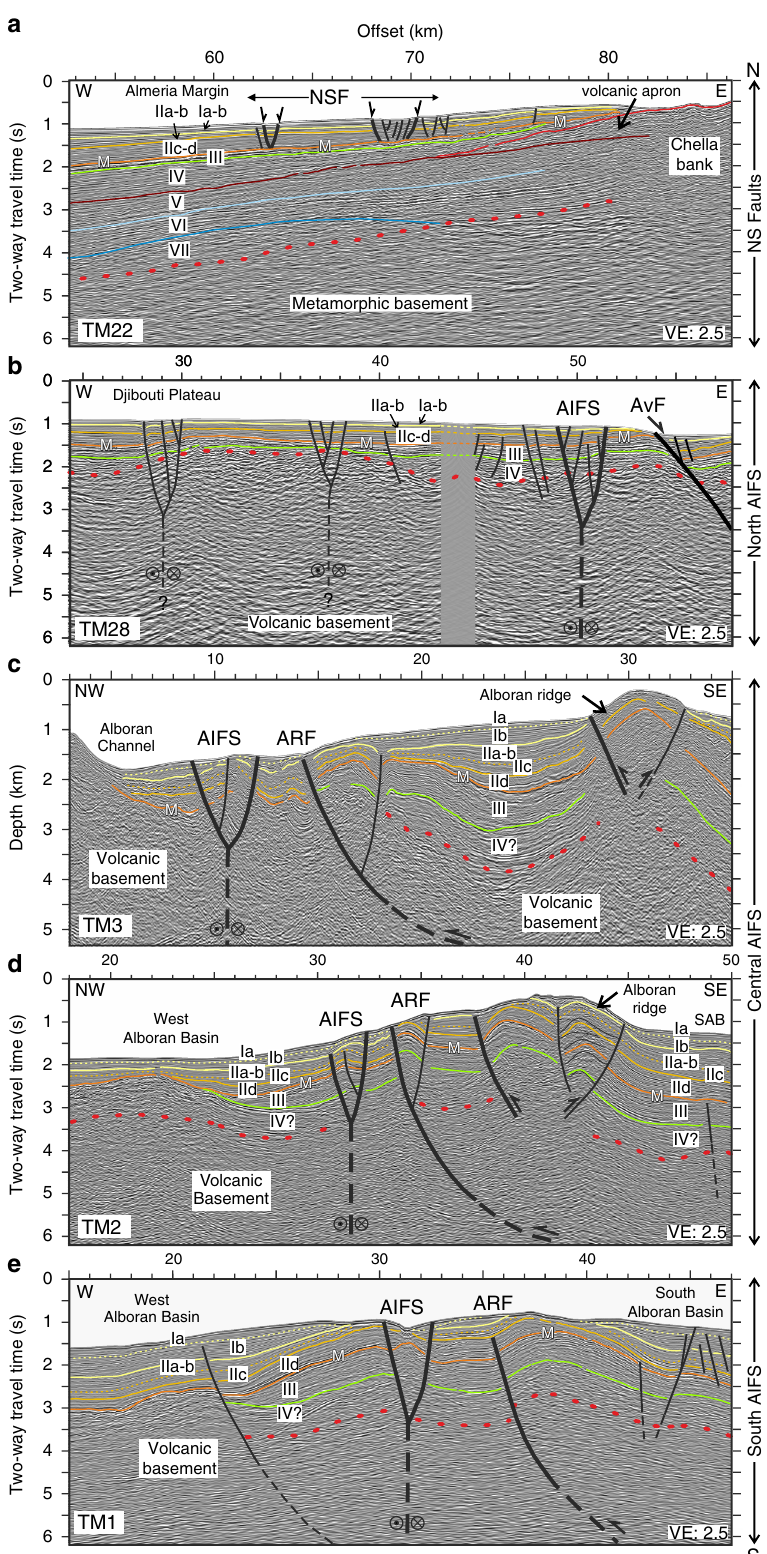
Fig. 4 Interpreted seismic re fl ection pro fi les across the AIFS. From north (top) to south (bottom), multichannel seismic pro fi les illustrate the geometry and tectonic pattern of the AIFS. The fi ve pro fi les are located in Fig. 2a. a NSF (pro fi le TM22); b North AIFS segment (pro fi le TM28); c Central AIFS segment - pressure ridge (pro fi le TM3); d Central AIFS segment - restraining bend (pro fi le TM2); and e South AIFS segment - releasing bend (pro fi le TM1). All pro fi les are plotted in two-way travel time (s) except for TM3, which is in depth (km). Ages of seismo-stratigraphic units are detailed in the text. AIFS: Al- Idrissi Fault System, ARFS: Alboran Ridge Fault System, AvF: Averroes Fault, M: Top Messinian horizon, SAB: South Alboran Basin